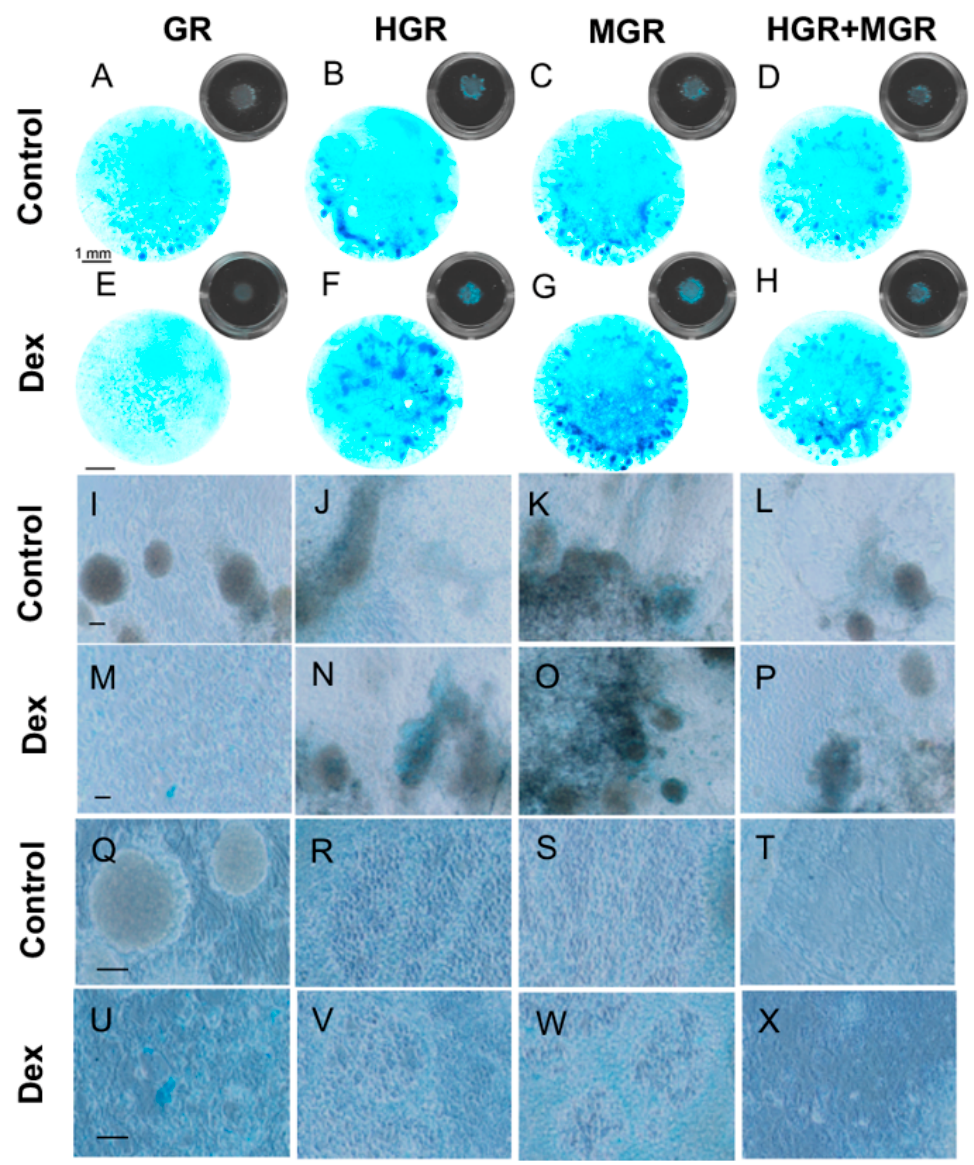
Figure 10. Activation of MSX-1 increases the proportion of Alcian blue-positive cells in micromass cultures. Cells were differentiated on PA6 cells for 8 days and replated as micromass aggregates for 10 additional days. In control conditions ( A – D , I – L and Q – T ), all cell lines presented a few Alcian blue-positive aggregates. The proportion of blue cells clearly increased after Dex addition ( E – H , M – P and U – X ), especially in MGR cells ( G , O and W ). Blue aggregates of cobblestone-like cells suggest the presence of chondrocytes ( R , S and W ), with larger cells that might correspond to hypertrophic chondrocytes ( T and X ) in the HGR + MGR cells. The black inset ( A – H ) show the well of the 24-well plate with the micromass growing on the center. The scale bars represent 1 mm ( A – H ), 500 μ m ( I – P ) and 100 μ m ( Q – X ).